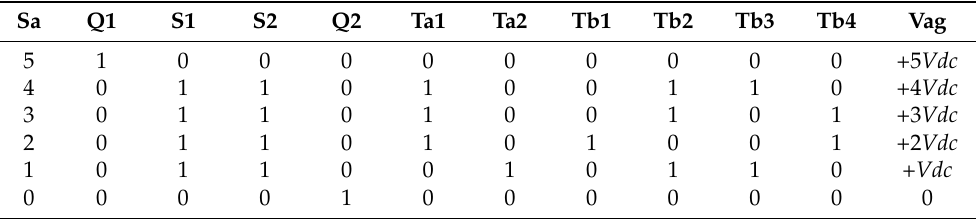
Figure 1. Proposed structure of a three-phase six-level inverter. Table 1. Switching states for the proposed six-level inverter ( Ma ≥